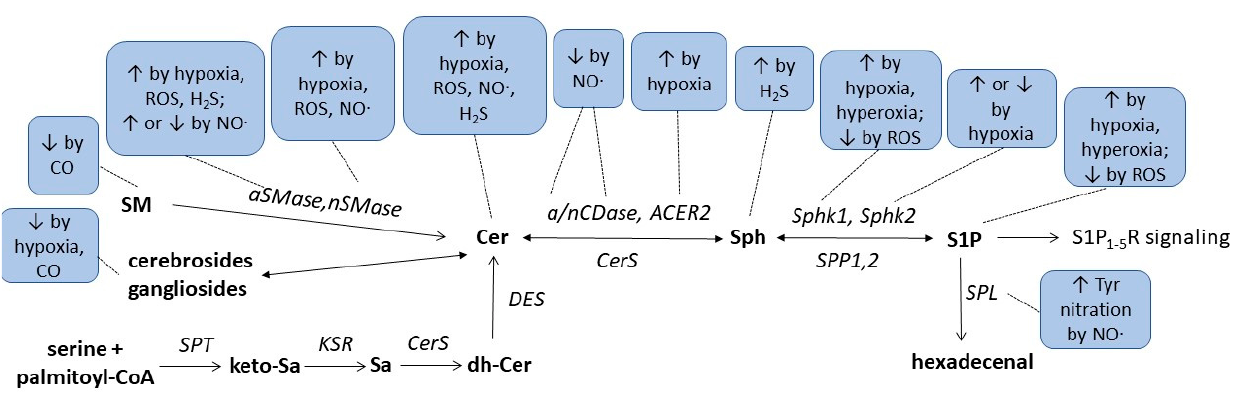
Figure 3. Summarizing scheme of gasotransmitters, hypoxia, and hyperoxia effects on sphingolipid metabolism. For abbreviations, see text. Table 1. Regulation of sphingolipids and their key enzymes by redox-active mediators.